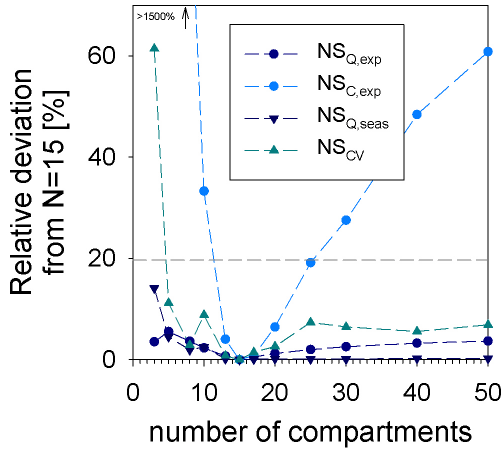
Fig. 8. Maximum relative deviation of NS efficiencies with varying number of compartments from the NS efficiencies using N = 15